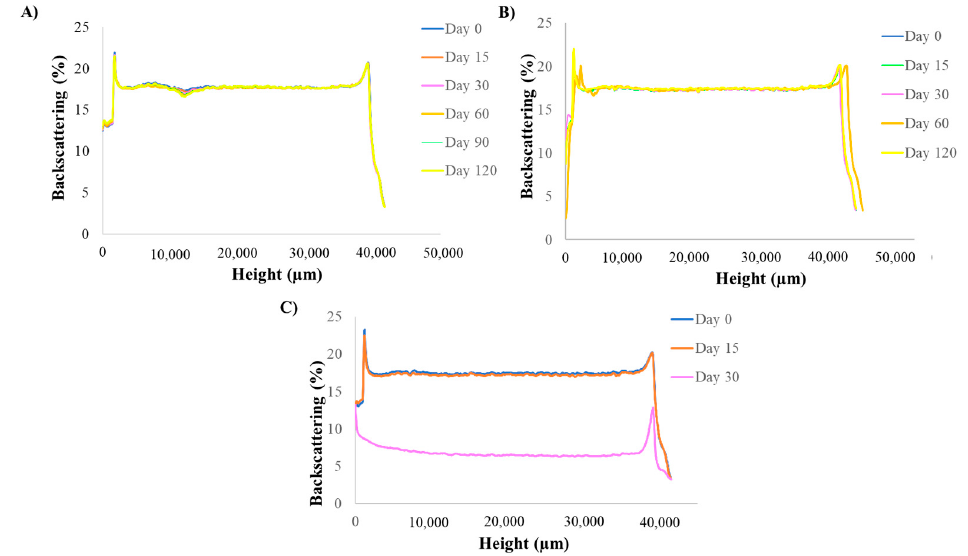
Figure 3. Turbiscan backcattering profile at different temperatures analyzed monthly. ( A ) 4 °C, ( B ) 25 °C and ( C ) 38 °C.